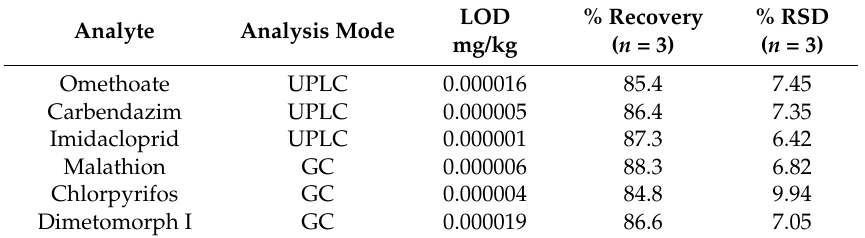
Table 3. Summary of the optimized parameters for the determination of pesticides residues in Nopal.